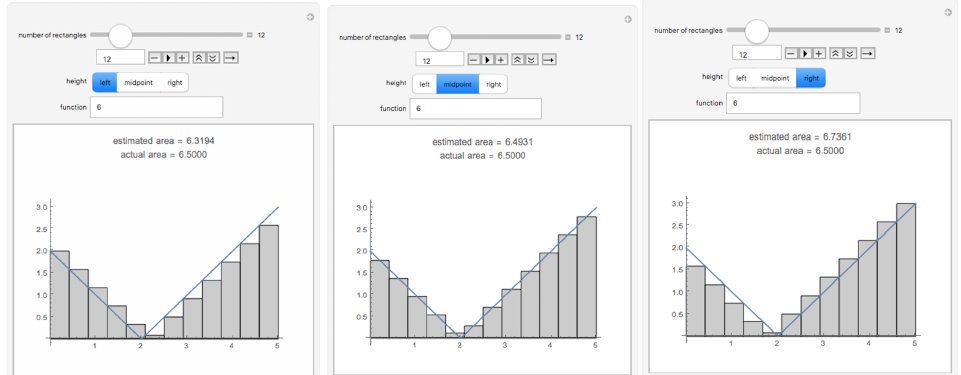
Figure 14. Example of three possible short-problems proposed to be solved individually, concerning the Riemann Sum concept.